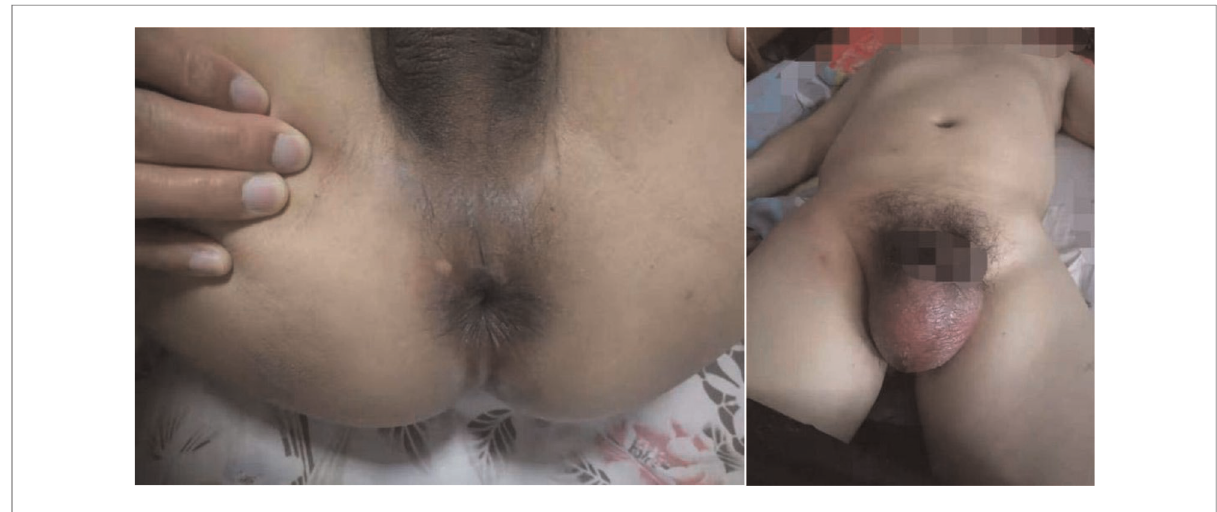
FIGURE 1 Initial abscess of patient